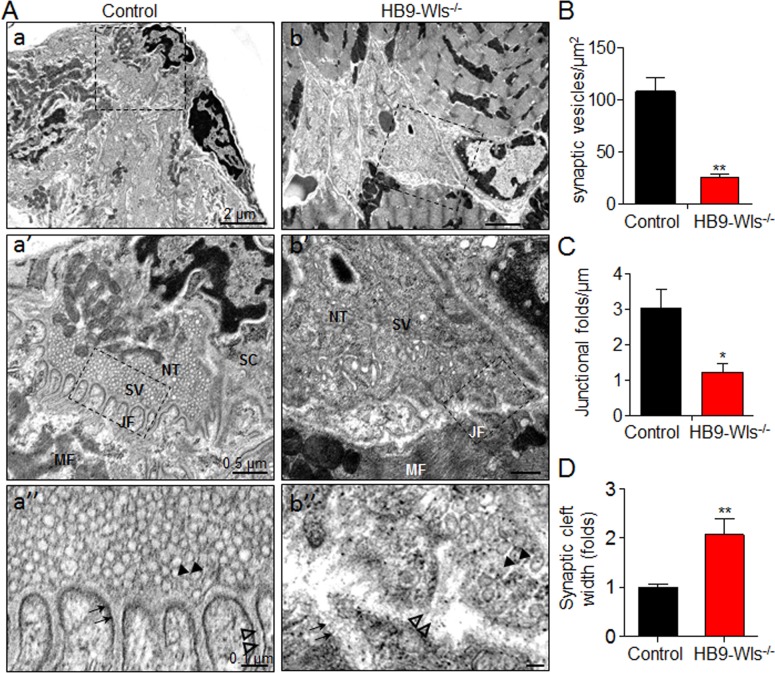
Disruption of NMJ ultrastructure in HB9-Wls-/- mutant mice.(A) Representative EM images of diaphragm NMJs in P15 control (a, a’, a’’) and HB9-Wls-/- mice (b, b’, b’’). Notice that there is a dramatic reduction of synaptic vesicles number in the HB9-Wls-/- (black arrowhead, (a’’ and b’’) and loss of synaptic junctional folds (black arrow, (a’’ and b’’) and basal lamina (empty arrowhead, (a’’ and b’’) in HB9-Wls-/-. Boxed regions are shown at higher magnification immediately below. NT, nerve terminal; MF, muscle fiber; SC, Schwann cell; SV, synaptic vesicle; JF, junctional fold. Scale bars: 2.0 μm (top); 0.5 μm (middle); 0.1 μm (bottom). (B) Synaptic vesicle density in two genotypes. n = 3 mice per group; Unpaired t-test, **p<0.01. (C) Number of synaptic junctional folds. n = 3 mice per group; Unpaired t-test, *p<0.05. (D) Synaptic craft width. n = 3 mice per group; Unpaired t-test, **p<0.01.